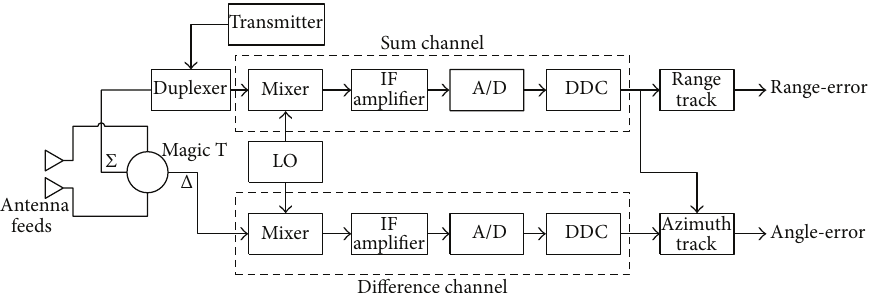
Figure 4: Block diagram of the sum-difference amplitude-comparison monopulse in azimuth coordinate.